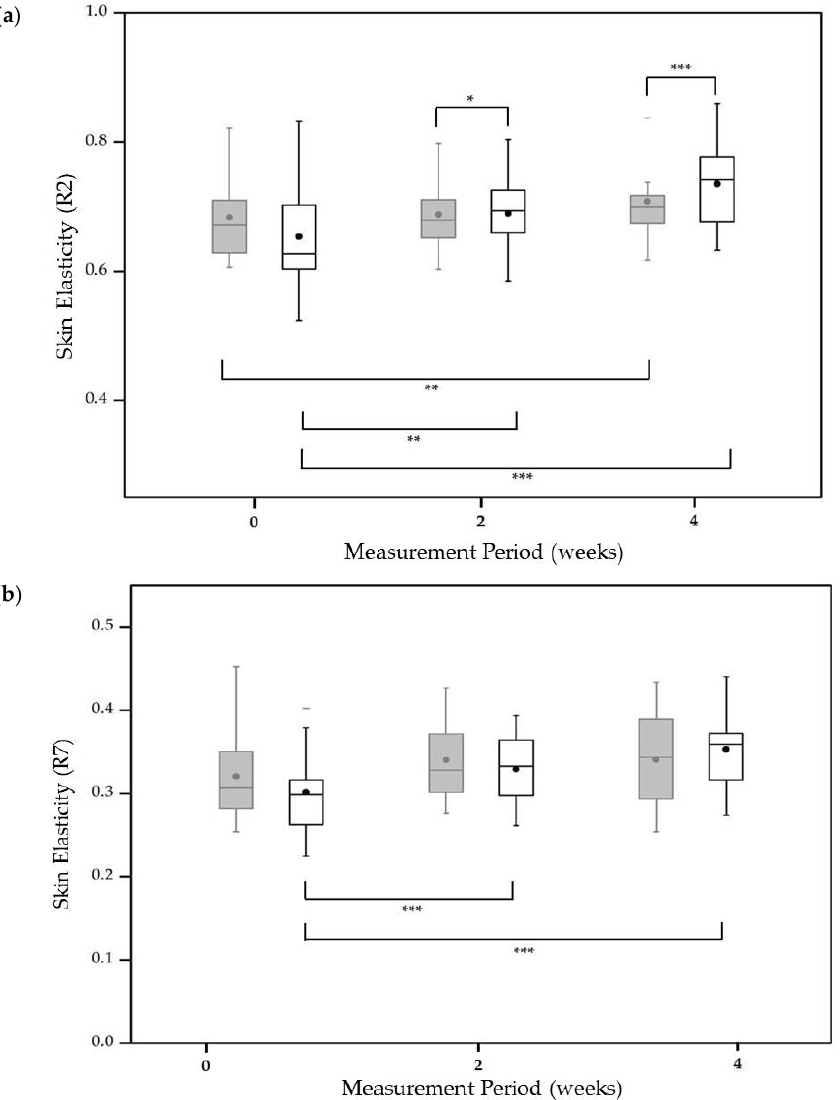
Figure 4. ( a ) R2 and ( b ) R7 skin elasticity before (0 weeks) and after (2 and 4 weeks) using the collagen peptide buccal delivery film of the control group (gray) and test group (white). The boxplot shows the average ( • ), median ( ), and max – min whiskers ( I ). The changes were significantly different between the control and test groups, before and after intake, with p < 0.05 (*), p < 0.01 (**), and p < 0.001 (***).